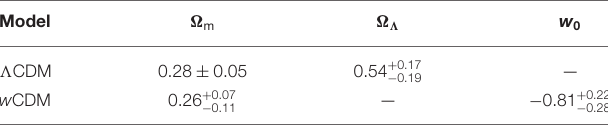
TABLE 1 | Prediction on the cosmographic parameters from the analysis of the eROSITA quasar Hubble diagram.